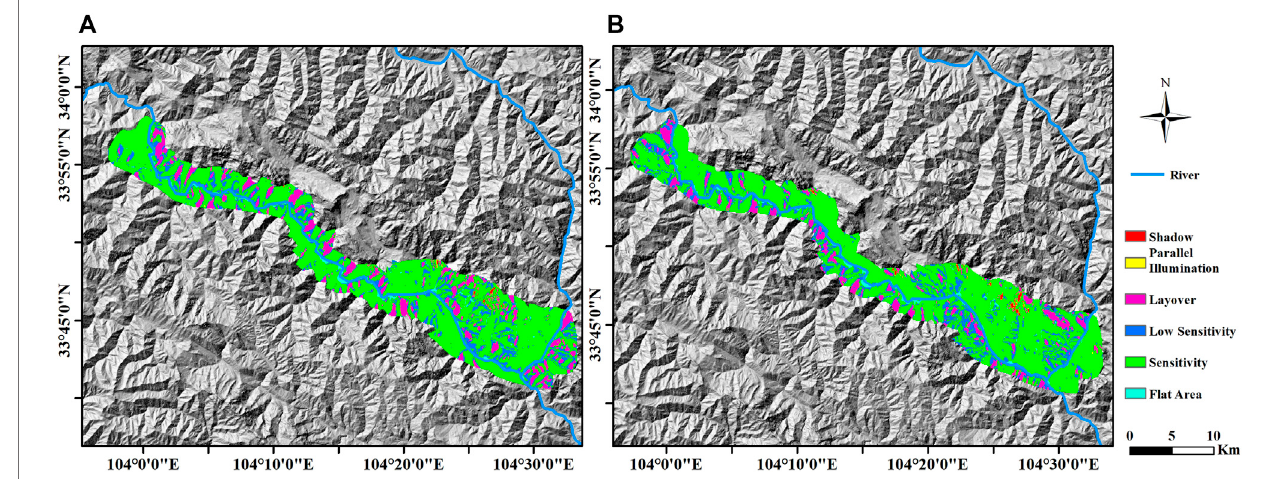
FIGURE 6 | Visibility results of sentinel-1A from the (A) ascending orbit and (B) descending orbit.